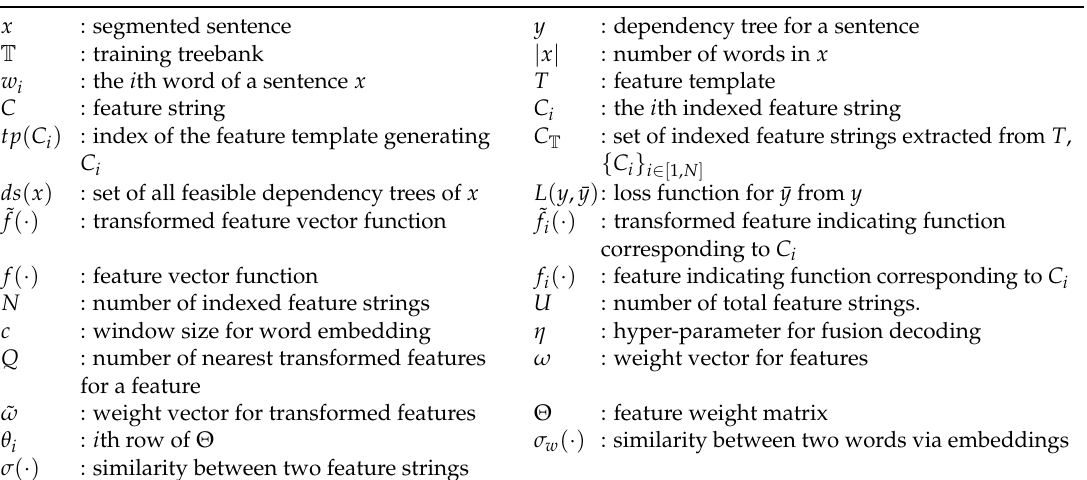
Figure 1. An example of dependency tree. Table 1. List of symbols used in this